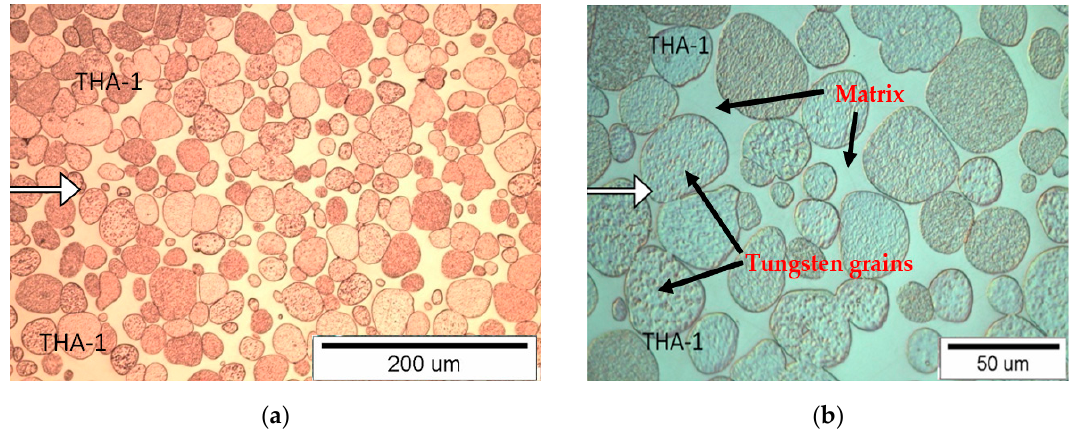
Figure 3. View of the microstructure of the THA-1 with THA-1 at a magnification of 200× ( a ) and 500× ( b ), (the connection line (joint) is shown by the arrow).